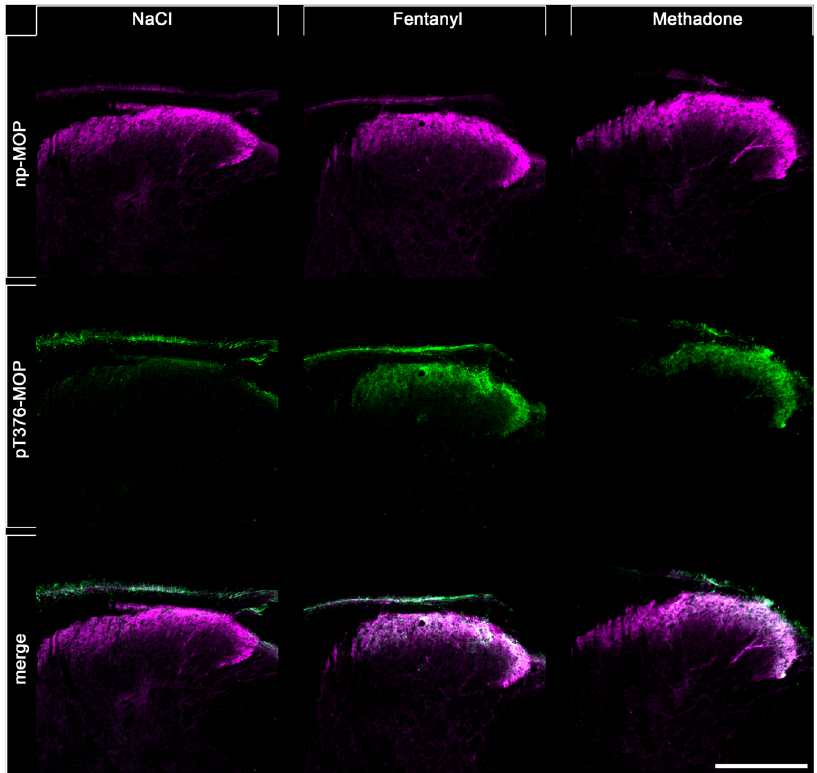
Fig. 6 Double staining of agonist-induced p-MOP and np-MOP in mouse brain. Animals were either treated with NaCl (30 min), Fentanyl (15 min) or Methadone (30 min). Animals were then transcardially perfused, fi xed and stained. Shown are confocal images of coronal sections of the spinal cord stained with phosphosite-speci fi c antibody pT376-MOP (green) and phosphorylation independent np-MOP antibody (magenta). Note that there is a strong overlap of np-MOP and pT376-MOP in the merged panels (white) in agonist treated animals compared to NaCl treated mice. Scale bar = 250 µ m.